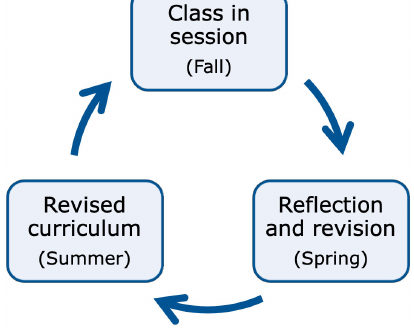
FIG. 1. Cycle of implementation and revision of the Physics GTA Preparation class. Figure adapted from Ref.